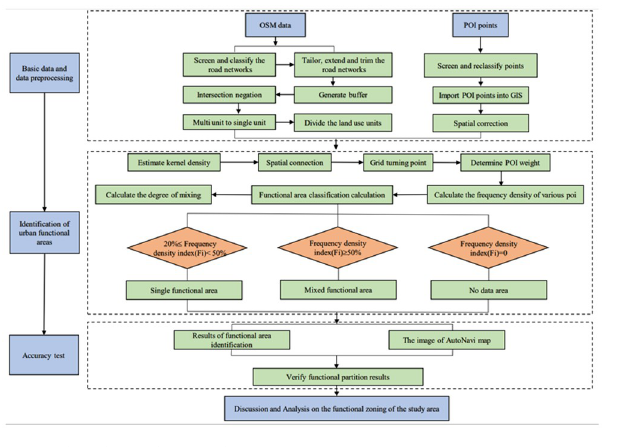
Fig 2. Flowchart of